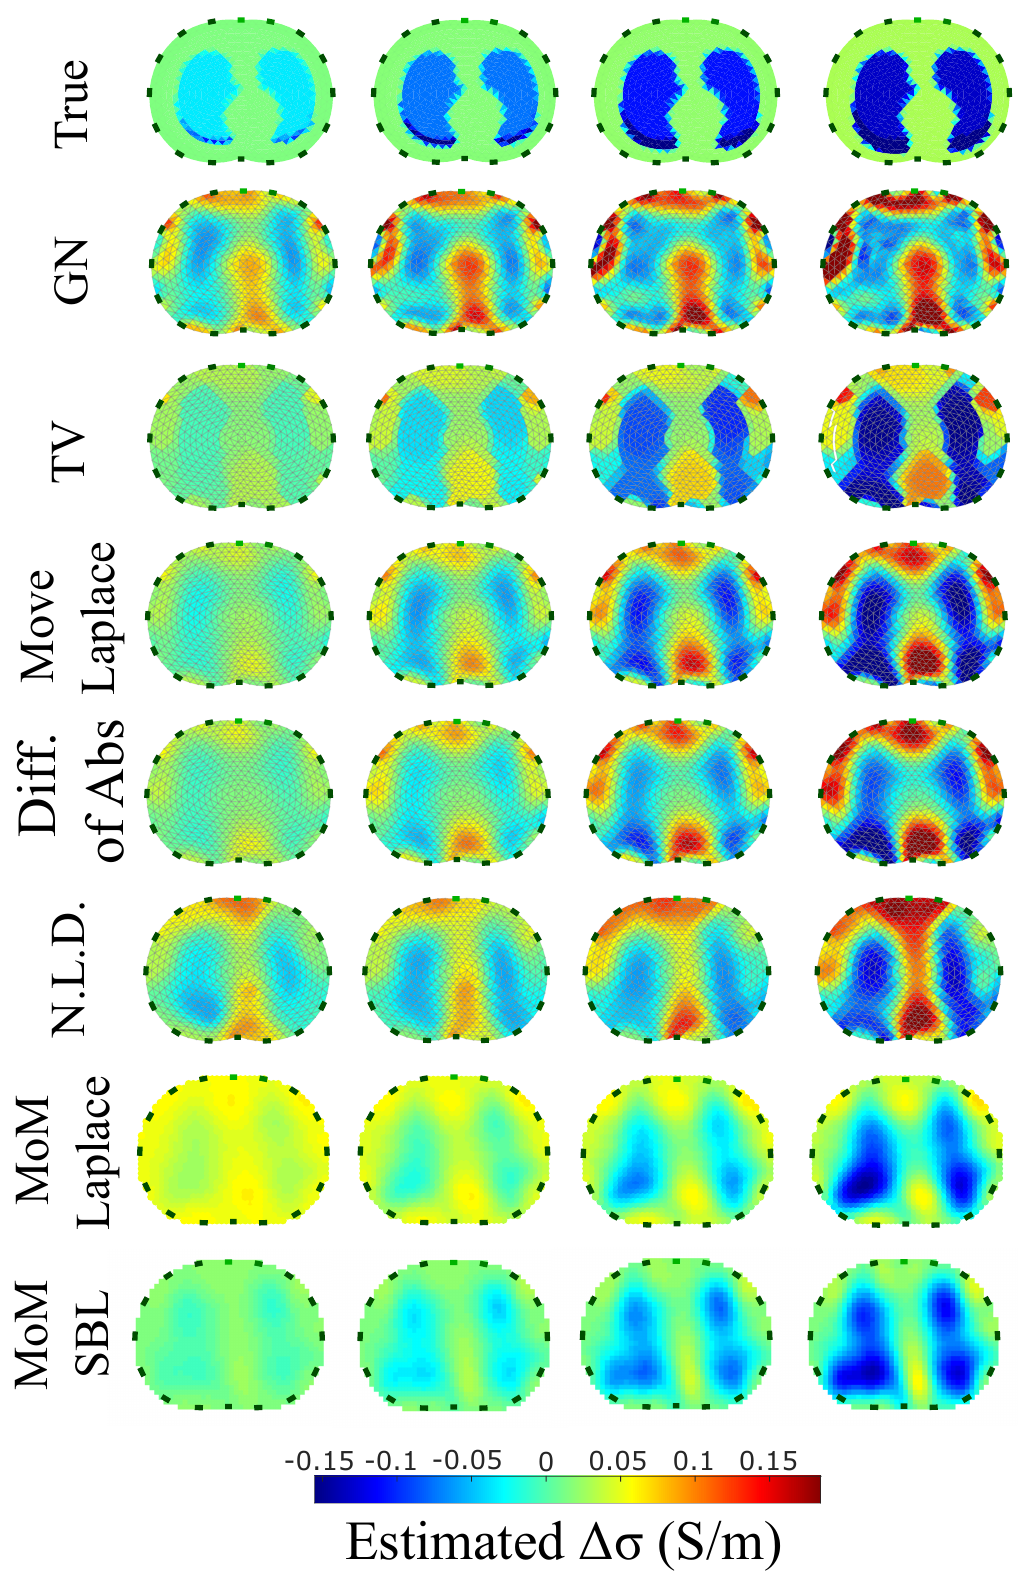
Figure 9. Reconstructed EIT images (conductivity differences) for the first